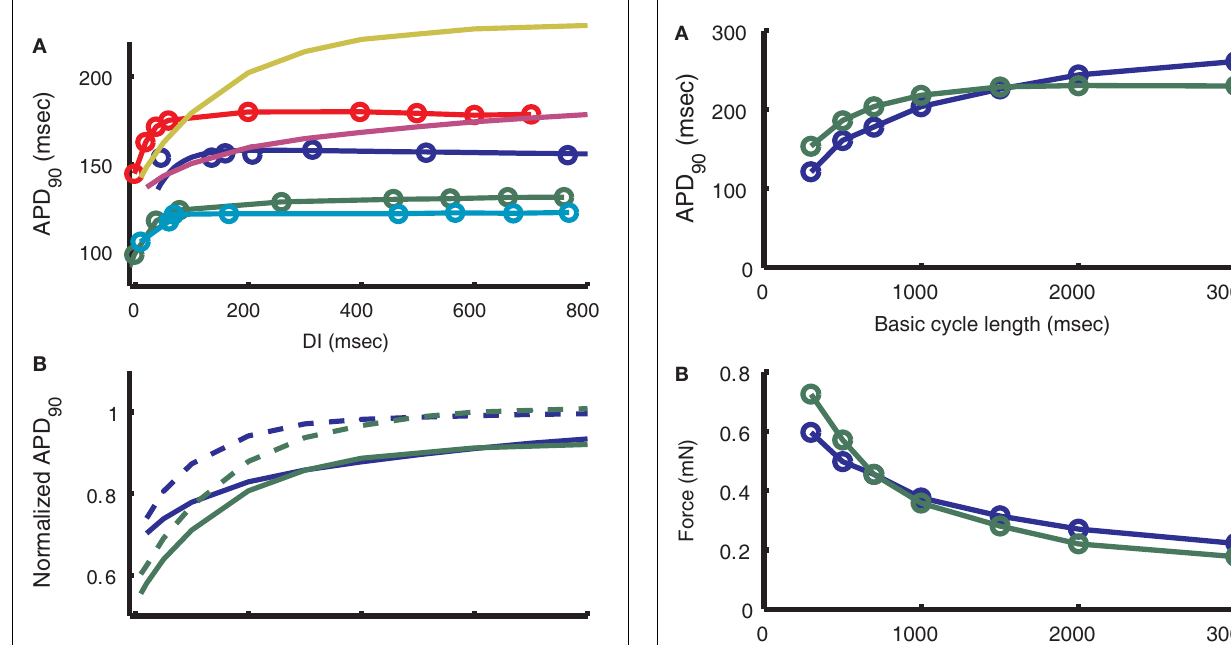
FIGURE 10 | Restitution ofAPD. (A) APD restitution curves from guinea pig experimental data and models. Blue dots show 2000ms BCL data from Bjornstad et al. (1993) connected by the biexponential fit reported by those authors. Green, red, and teal respectively show epicardial, midmyocardial, and endocardial experimental data from Sicouri et al. (1996).The purple line depicts output from the LRd07 model (Faber et al., 2007) and yellow is from the present model. A standard S1–S2 protocol was used to simulate APD restitution, starting from 0.5Hz steady-state as in the protocol used by Sicouri et al. (1996).The single exponential time constant for restitution of the present model is 165ms, compared with approximately 40ms for Bjornstad et al. (1993) and approximately 46, 27, and 31ms for Sicouri et al. (1996) epicardial, midmyocardial, and endocardial, respectively. (B) Alteration of the model restitution curve by reverting to the unmodified IKs formulation from Zeng et al. (1995). Blue is LRd07 model, green is the present model. Solid lines are simulations using the latest IKs formulation (one fast gate, one slow), dashed lines are for simulations with 1995 IKs formulation (two fast gates). Curves are normalized to the 2000-ms steady-state APD 90 for each model, respectively.